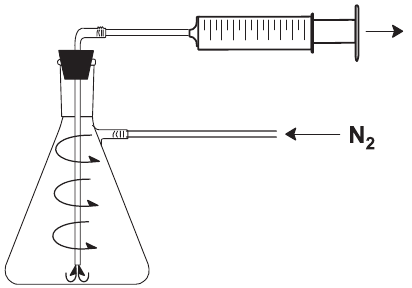
figure 2. co 2 sampling chamber used to regenerate co 2 gas from alkali traps for